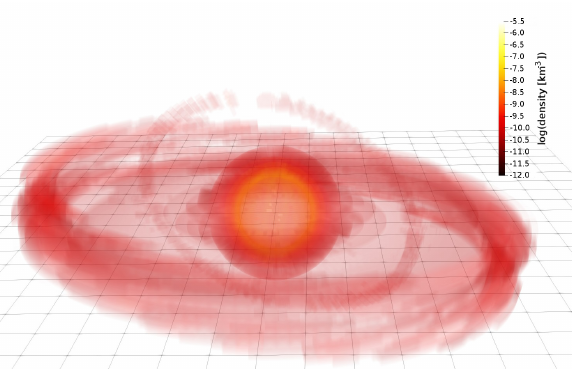
Figure 14. Space debris model elaborated by ISON in KIAM RAS, the outer ring corresponds to the geostationary